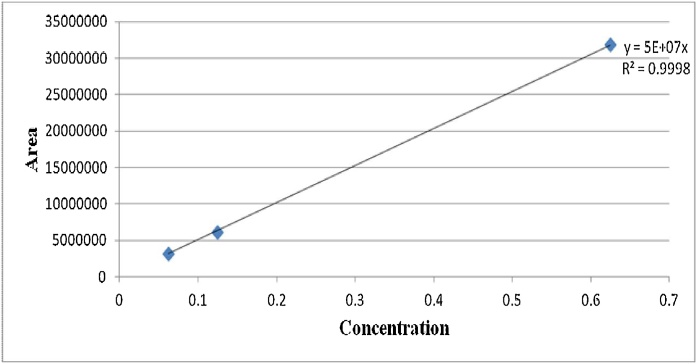
Standard curve for AFB1.